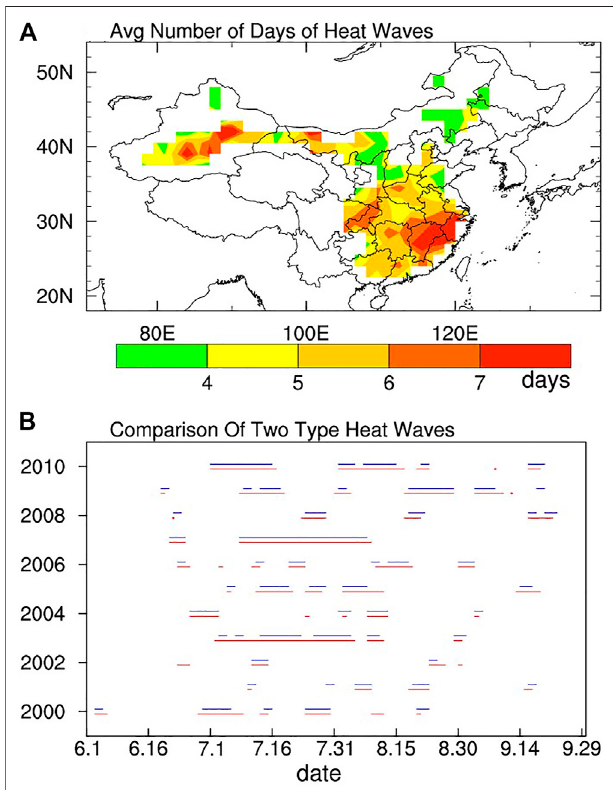
FIGURE 2 | (A) The number of average persistent days of the observed heat wave identi fi ed by HWI, and (B) comparison for the period of heatwaves in this study (red line) and in Lin et al. (2021) (blue line) over Huanan from 2000 to 2010 (B) .